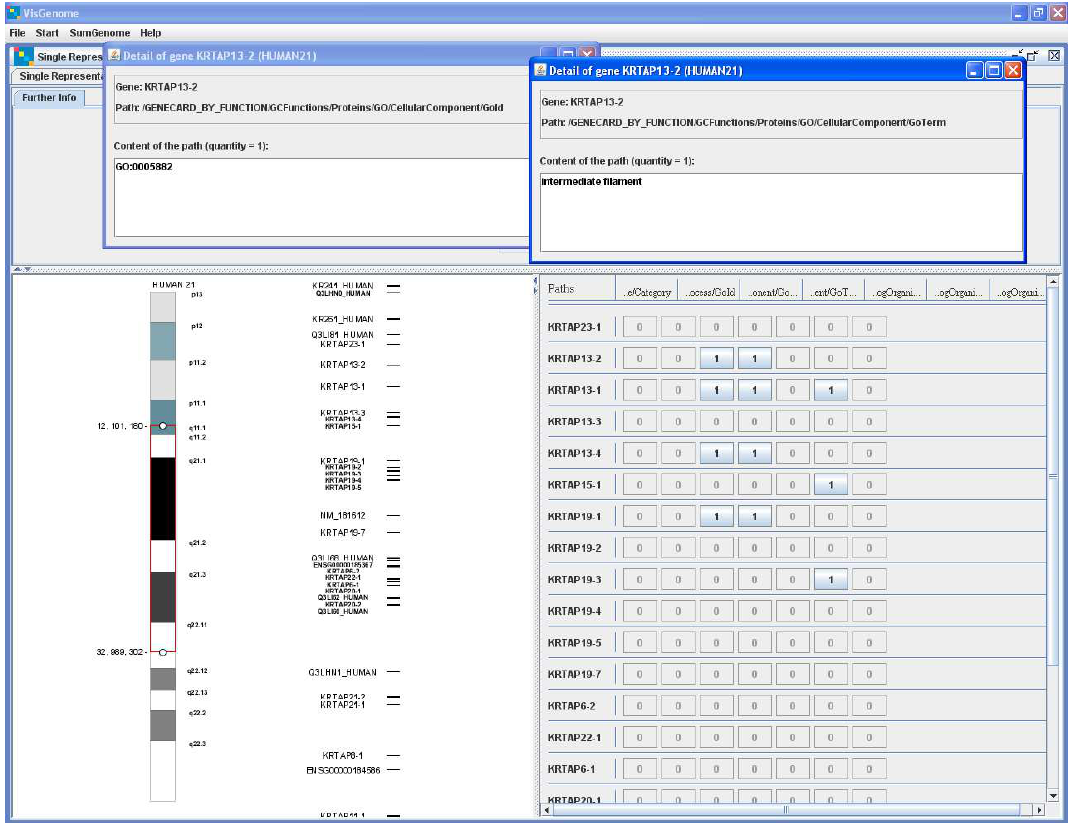
Figure 5: A map if human chromosome 21 showing genes. To the right of the genes, a panel of boxes shows path statistics for each selected path (column) and gene (row). Clicking on buttons showing counts fires queries which deliver XML values for each gene/path combination, shown above the map panel. This allows the user to verify her understanding of the information encoded by the XML paths she selected and evaluating data